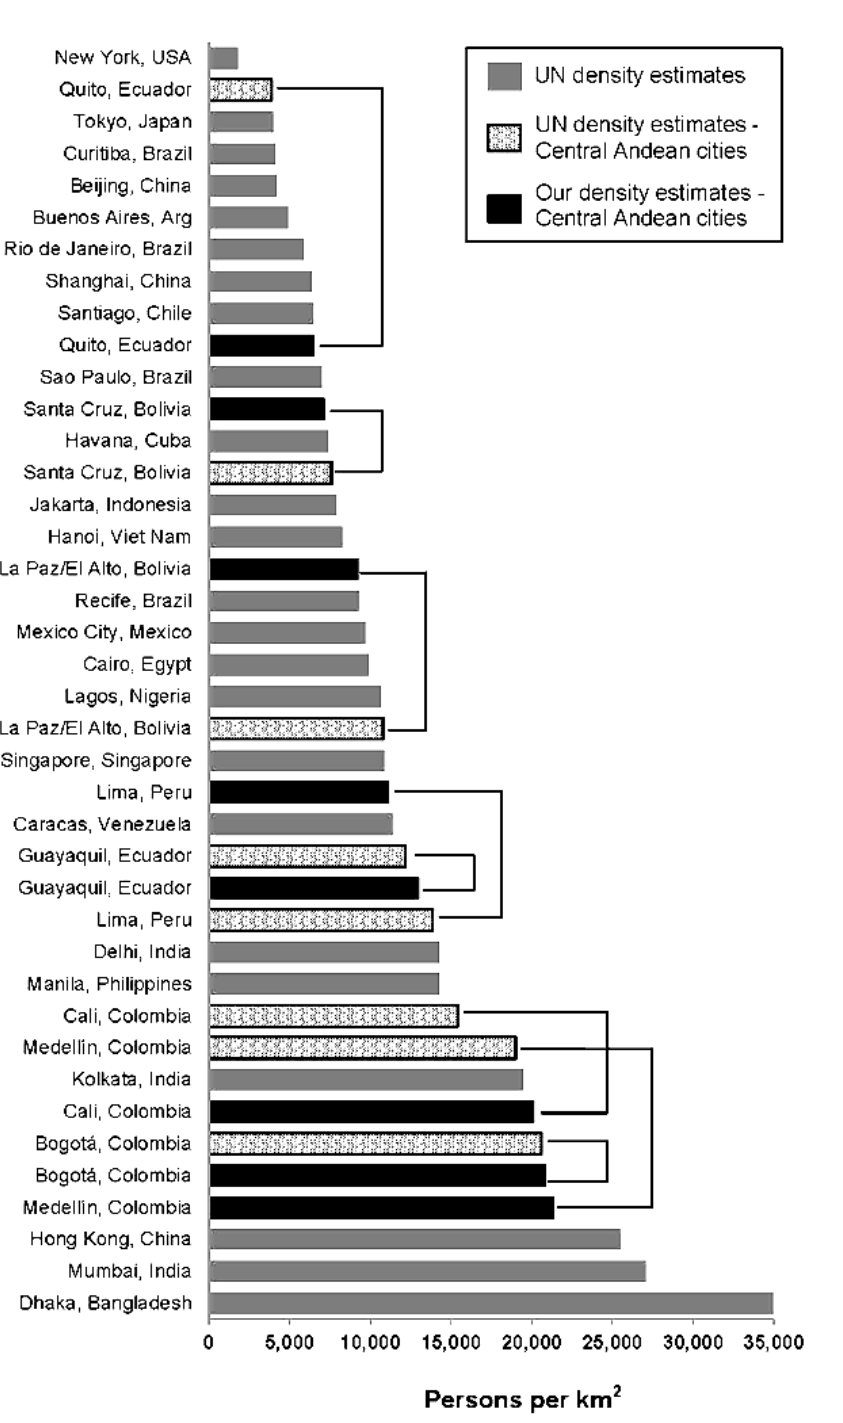
Figure 6. Comparison of our estimates of urban population density in Andean cities with the densities of other Latin American cities and major cities around the world, according to the United Nations estimates for urban agglomerations